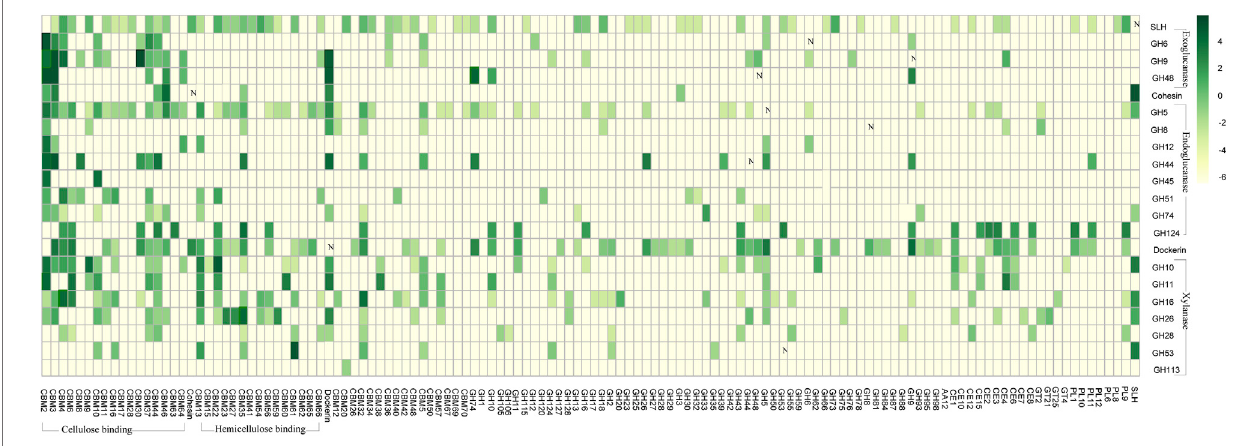
FIGURE 3 | Frequencies of the CAZy modules co-occurring with each other in same genes. Vertically listed are the twenty-one selected CAZy modules, including the four exoglucanase GH modules, the seven endoglucanase GH modules, the seven xylanase GH modules, the cohesion module, the dockerin module, and the SLH module. The CAZy modules lining horizontally are those modules being observed in same genes as at least one of the 21 vertically listed CAZy modules. Co-occurring frequencies are presented in log format-lg (x+0.01) as indicated in the scale bar, and the plain numbers “ x ” denoting the co-occurring frequencies could also be found in Supplementary Appendix S1 .